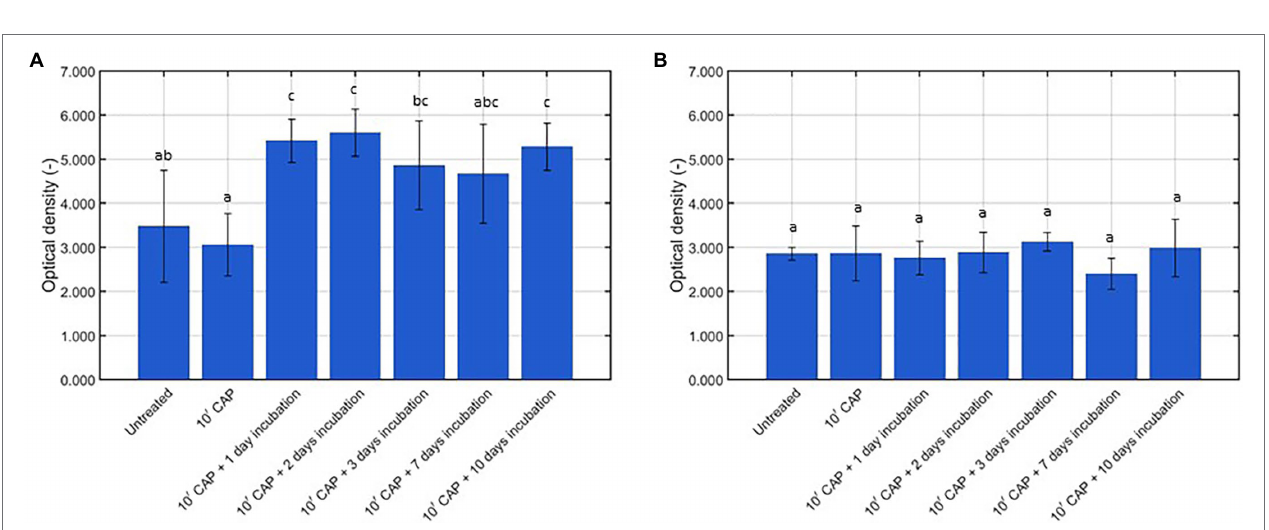
FIGURE 3 | Optical density (OD; -) following crystal violet staining of the untreated, CAP treated, and CAP treated + incubated model biofilms ( n = 5). (A) Listeria monocytogenes model biofilms and (B) Salmonella Typhimurium model